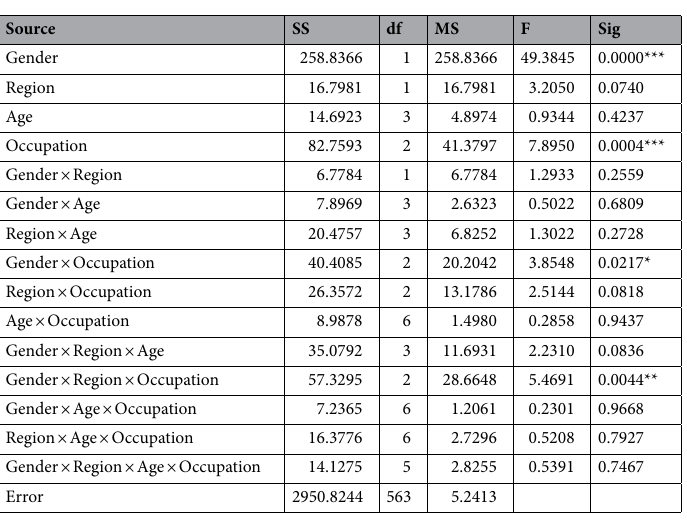
Table 8. Four-way analysis of variance of personal protective measures with gender, region, age, and occupation. * p < .05, ** p < .01, *** p < .001.